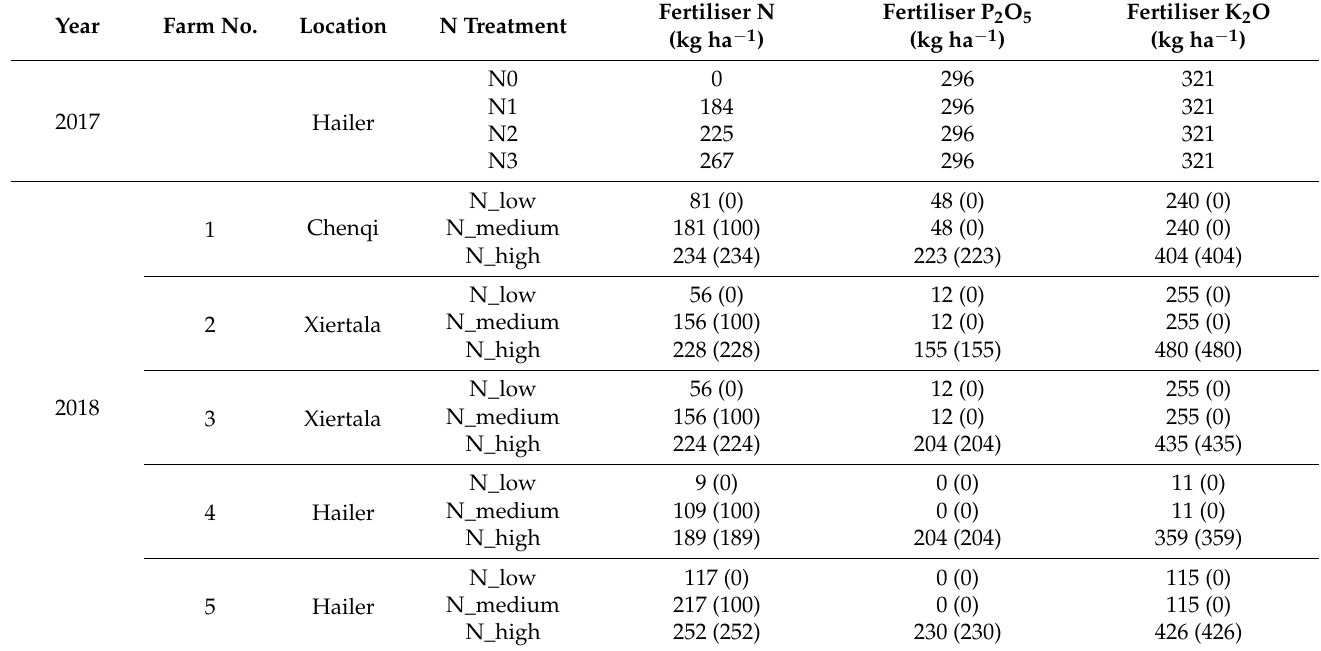
Table 1. The nitrogen (N), phosphorus (P 2 O 5 ), and potassium (K 2 O) fertiliser input of the 2017 and the 2018 N experiments. For 2018 experiment, the values in brackets represent the targeted N, P, K fertiliser inputs, while the left values indicate the actual N, P 2 O 5 , K 2 O